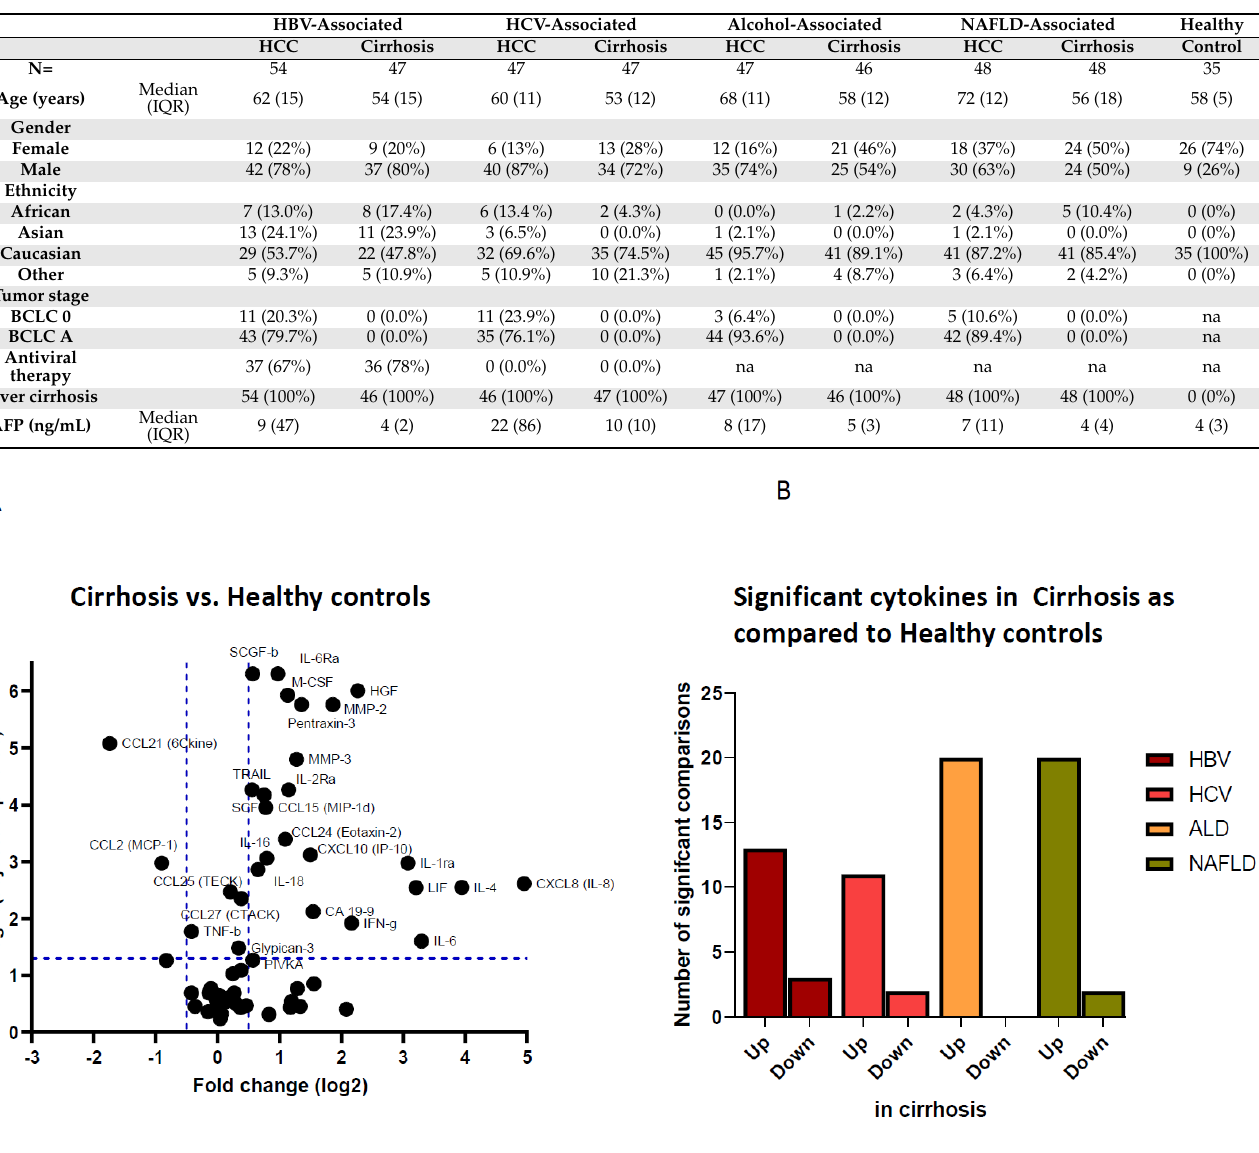
Table 1. Characteristics of the HBV-, HCV-, Alcohol- or NAFLD-associated early-stage hepatocellular carcinoma (HCC) and liver cirrhosis patients (WHO PS 0, Child-Pugh A-B). Barcelona Clinic Liver Cancer prognosis and treatment stage; BCLC.